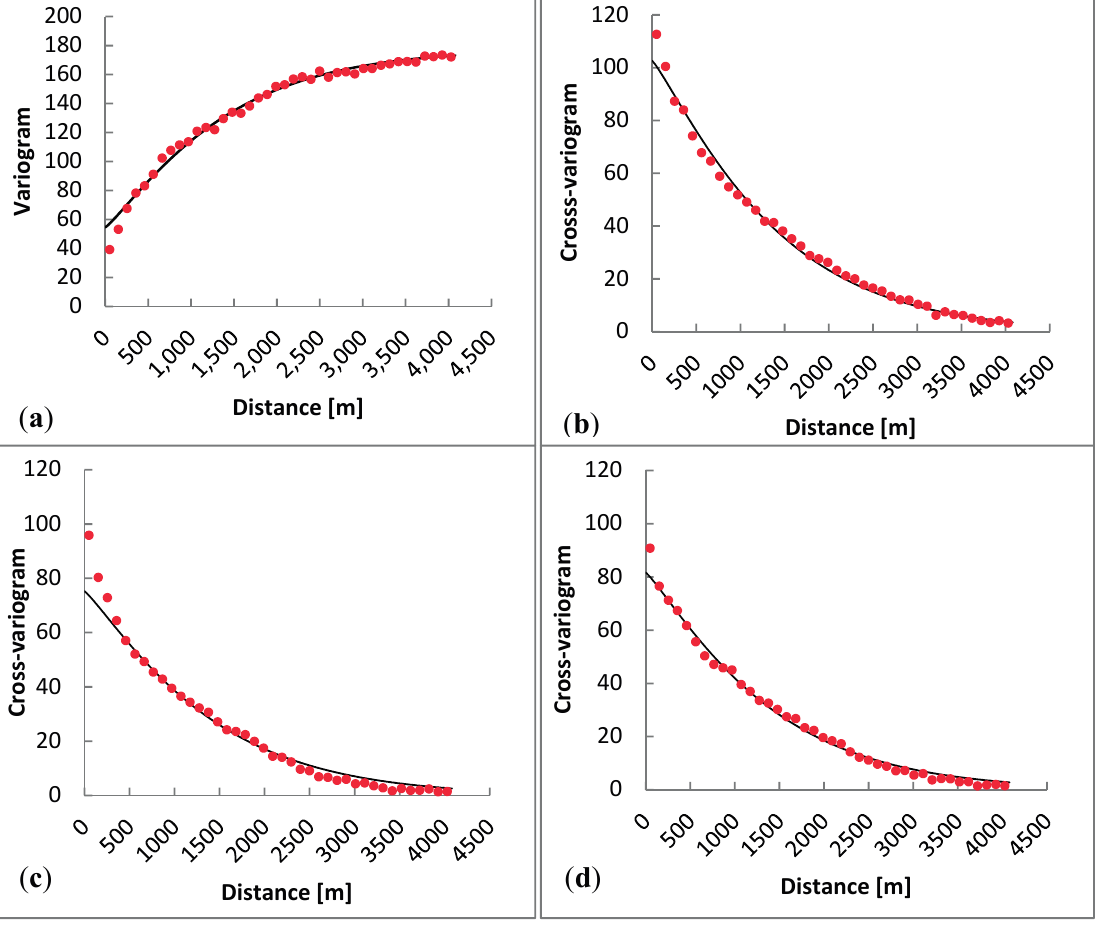
Figure 6. ( a ) Experimental semi-variograms (red dots) and model fits (black line) for topsoil clay content extracted from Landsat TM5 image acquired on 2 September 2009; ( b ) Cross-variogram between clay content from 2 September 2009 and 18 September 2009; ( c ) Cross-variogram between clay content from 2 September 2009 and 1 August 2009; ( d ) Cross-variogram between clay content from 2 September 2009 and 16 July